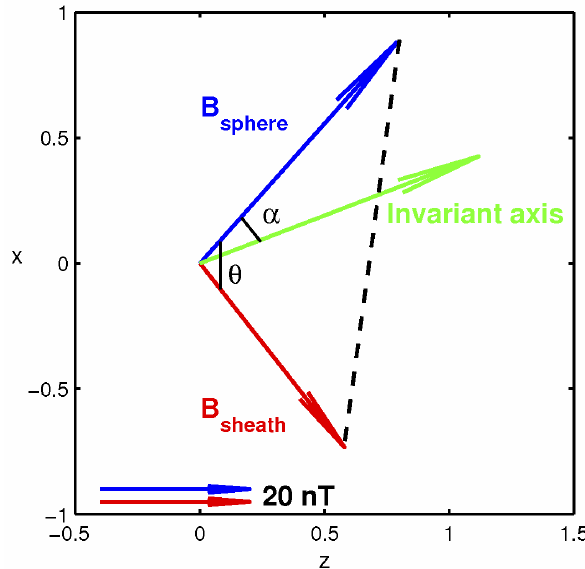
Fig. 8. Schematic, in a plane tangential to the magnetopause, of magnetic fields and invariant axis (X-line). The horizontal (vertical) axis is along the intermediate (maximum) variance direction from MVAB0. The scale is arbitrary. The angle α is 28 ◦ for the axis (green arrow) deduced from the reconstructions (Hasegawa et al., 2004). For the model proposed by Sonnerup (1974), α = 56 ◦ , i.e. the axis is perpendicular to the dashed line; the bisector of the angle θ is at α = θ/ 2 = 50 ◦ , and the angle predicted by Swisdak and Drake (2007) is at α = 34 ◦